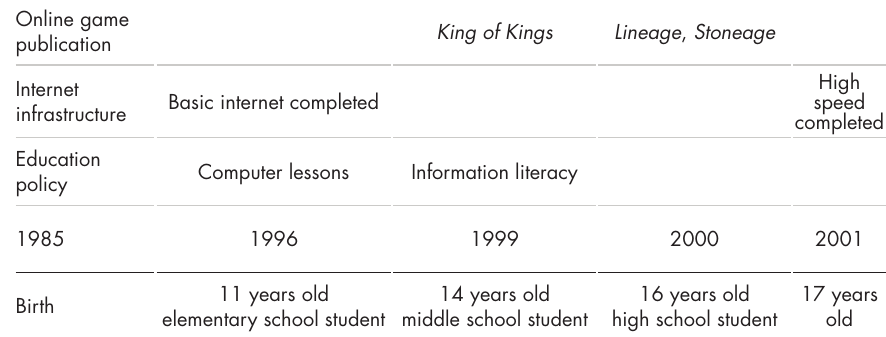
Table 1 Social context of the fi rst game generation in